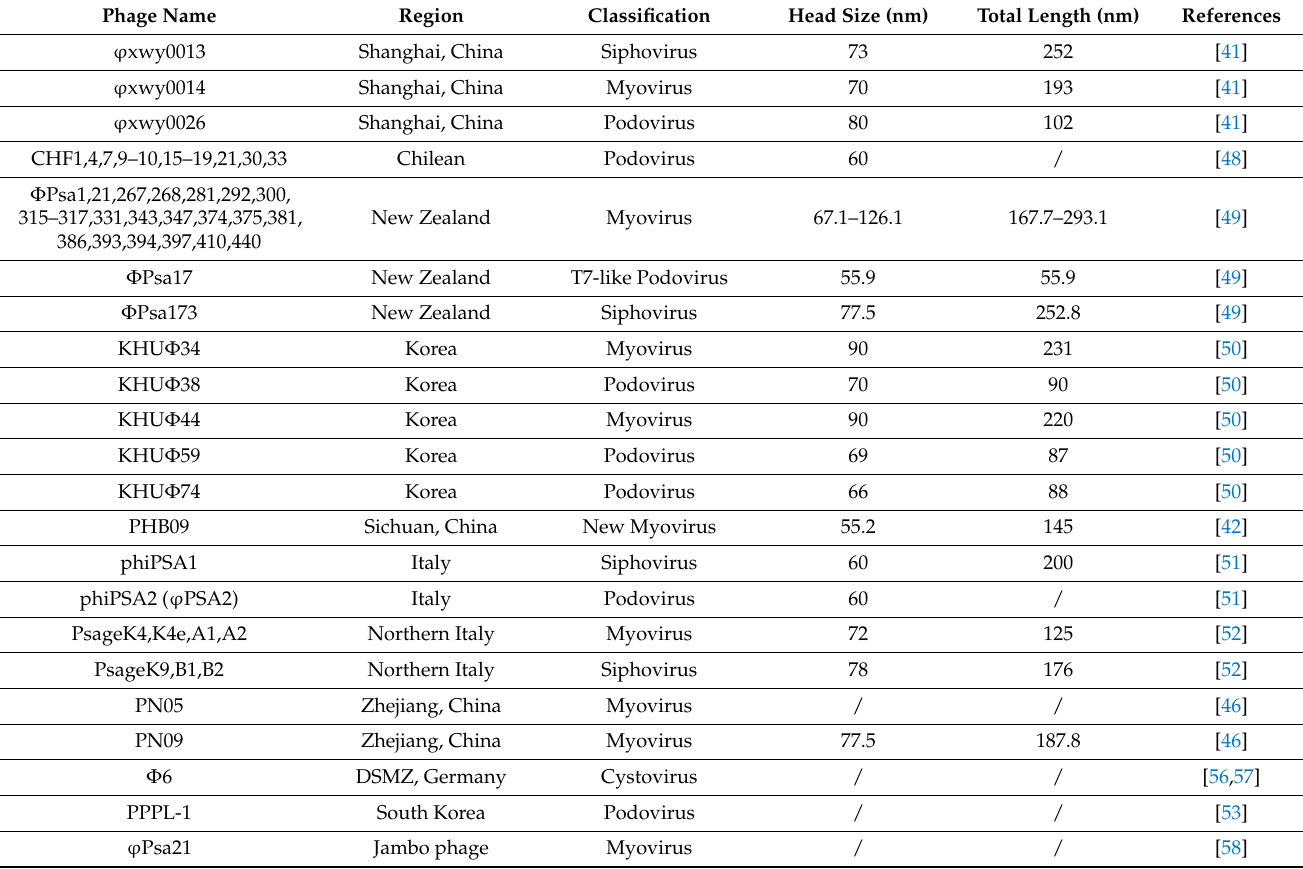
Table 1. Morphological characterization of some Psa